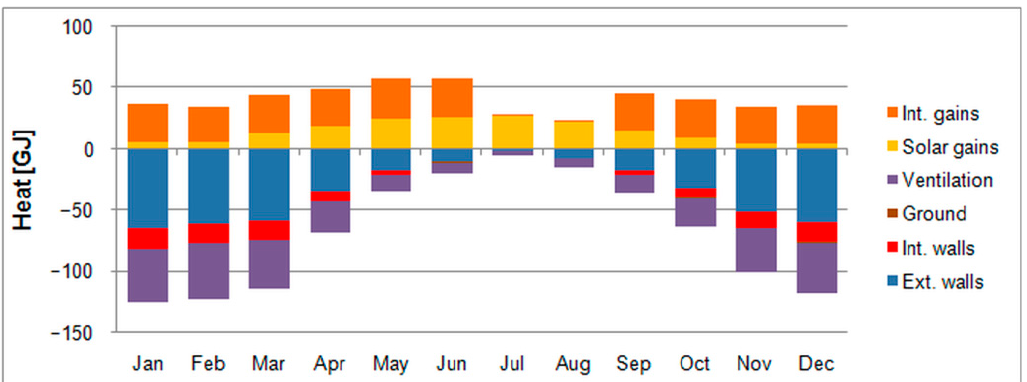
Figure 4. Heat gains and losses in the building before modernization.